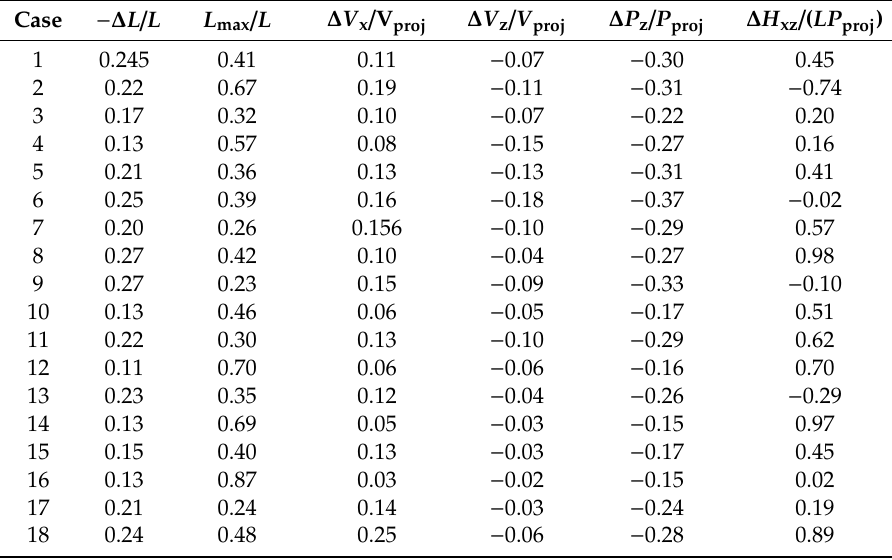
Table 3. Change in length, velocity, linear momentum, and angular momentum.